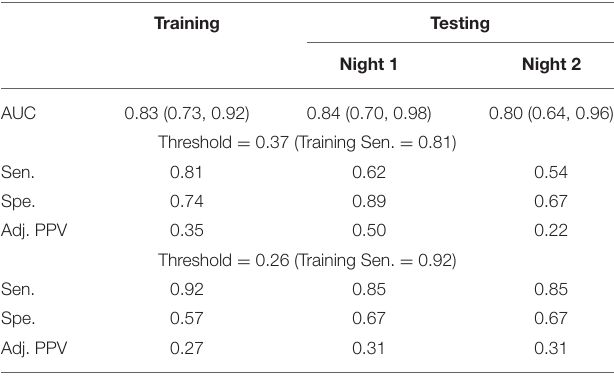
TABLE 3 | Area under the receiver operating characteristic curve (AUC) for a logistic regression model consisting of the three features shown in Table 4 and developed by combining data from both nights of the training set.